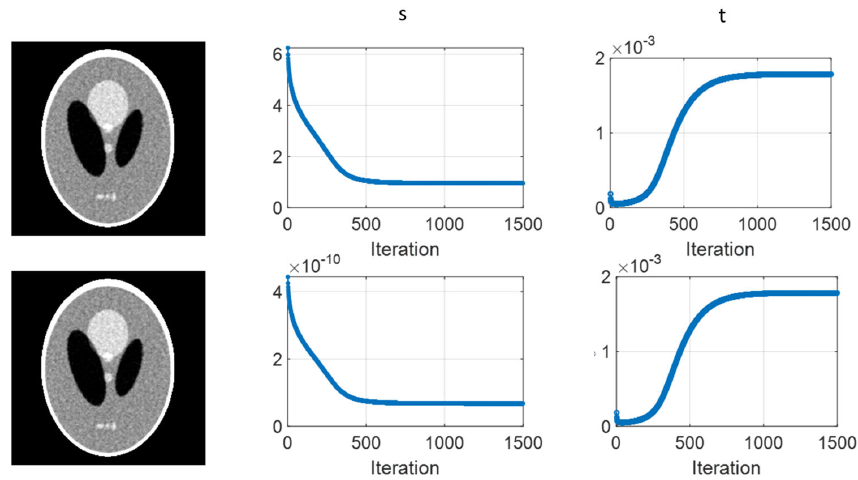
Figure 9. Performance of joint ‐ parameter ‐ Bayes images for 𝝆 (cid:2870) without ( upper ) and with normali ‐ zation ( lower ) by 𝑠𝑢𝑚(cid:4666)𝝆 (cid:2870) (cid:4667) (cid:3404) 1 . The CT image display window is [0, 0.035] mm − 1 .